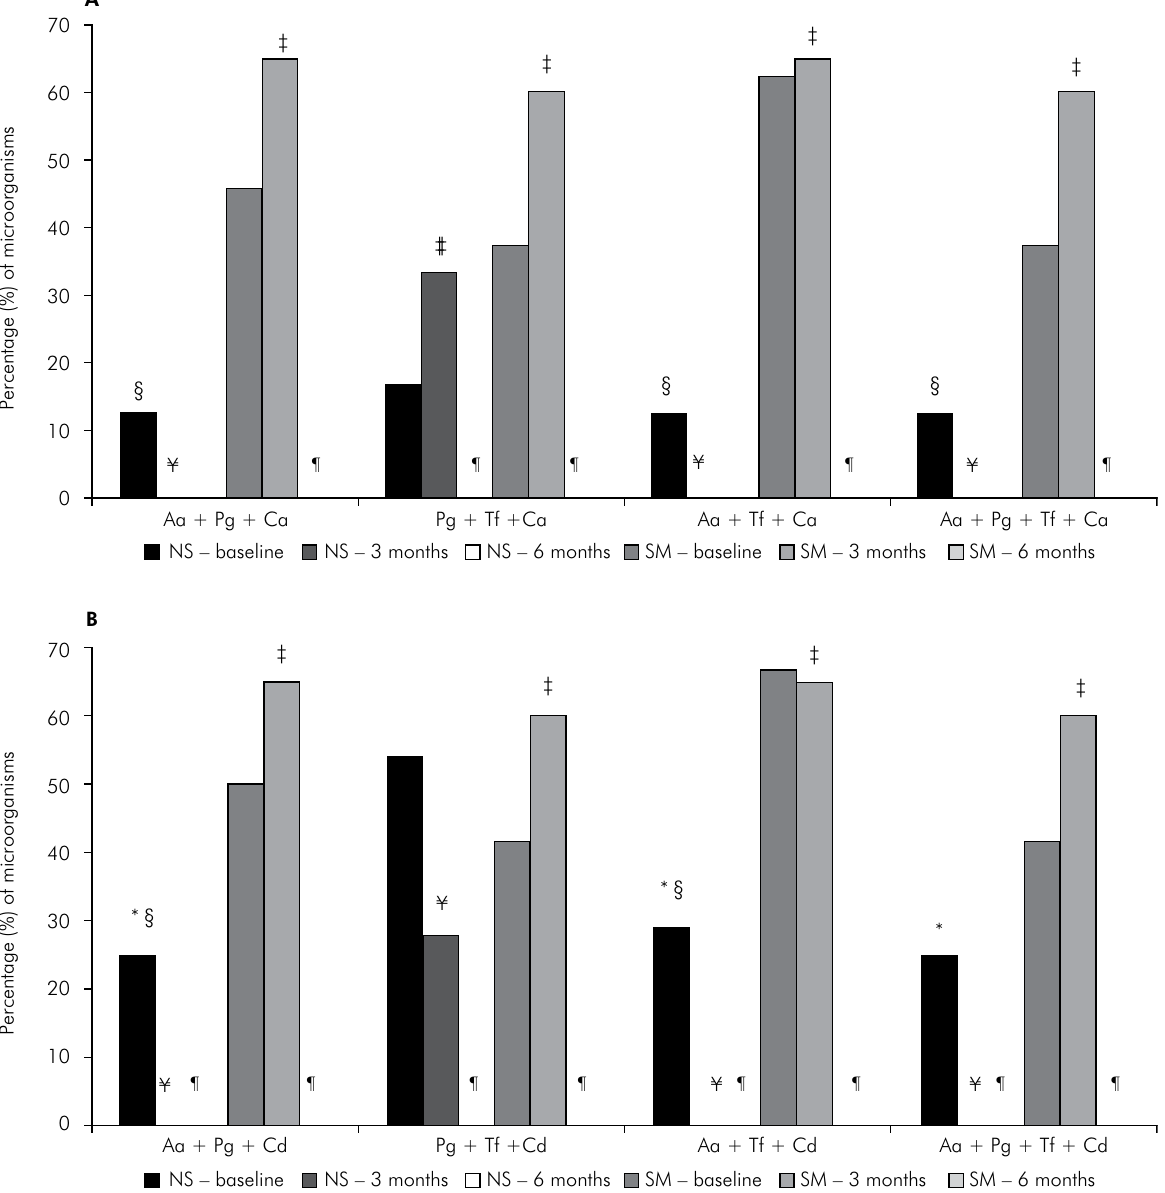
Different lower-case letters show statistical difference among time points, considering each condition separately (NS and SM), according to Kruskal-Wallis and Mann-Whitney tests; *Statistically significant difference between baseline and 3 months, considering each group separately (Wilcoxon’s test; p < 0.05); ¶ Statistically significant difference between baseline and 6 months, considering each group separately (Wilcoxon’s test; p < 0.05); ‡ Statistically significant difference between 3 months and 6 months, considering each group separately (Wilcoxon’s test; p < 0.05); § Statistically significant differences between SM and NS groups for baseline (Mann Whitney test; p < 0.05); ¥ Statistically significant differences between SM and NS groups for 3 months (Mann Whitney test; p < 0.05); There were no statistical difference between SM and NS groups for 6 months (Mann Whitney test, p < 0.05). Figure 2. Combinations of bacteria and Ca (A) or Cd (B) from smokers and nonsmokers after time points of periodontal treatment. Values expressed in n(%) of sites harboring the